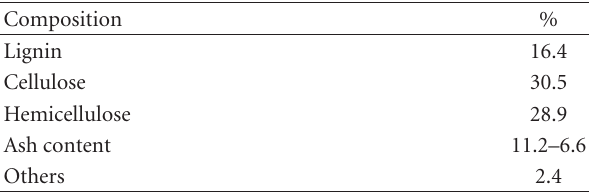
Table 1: Chemical composition of wheat husk fibers (WHFs). Composition